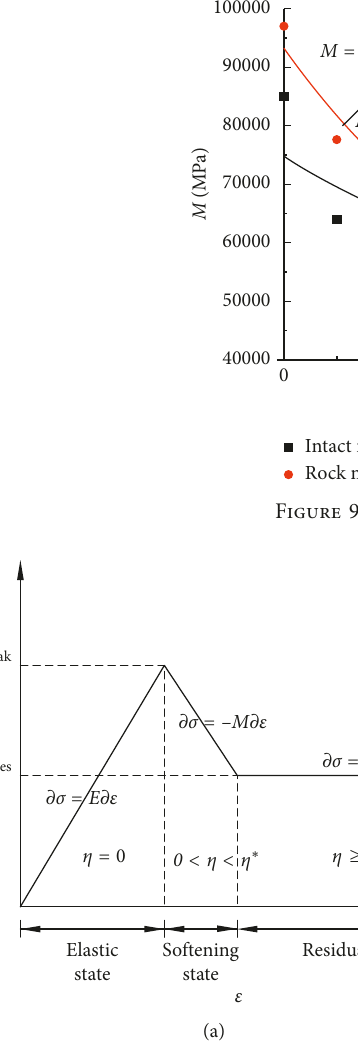
Figure 10: Strain-softening constitutive model. (a) Stress-strain relationship. (b) Strength model.